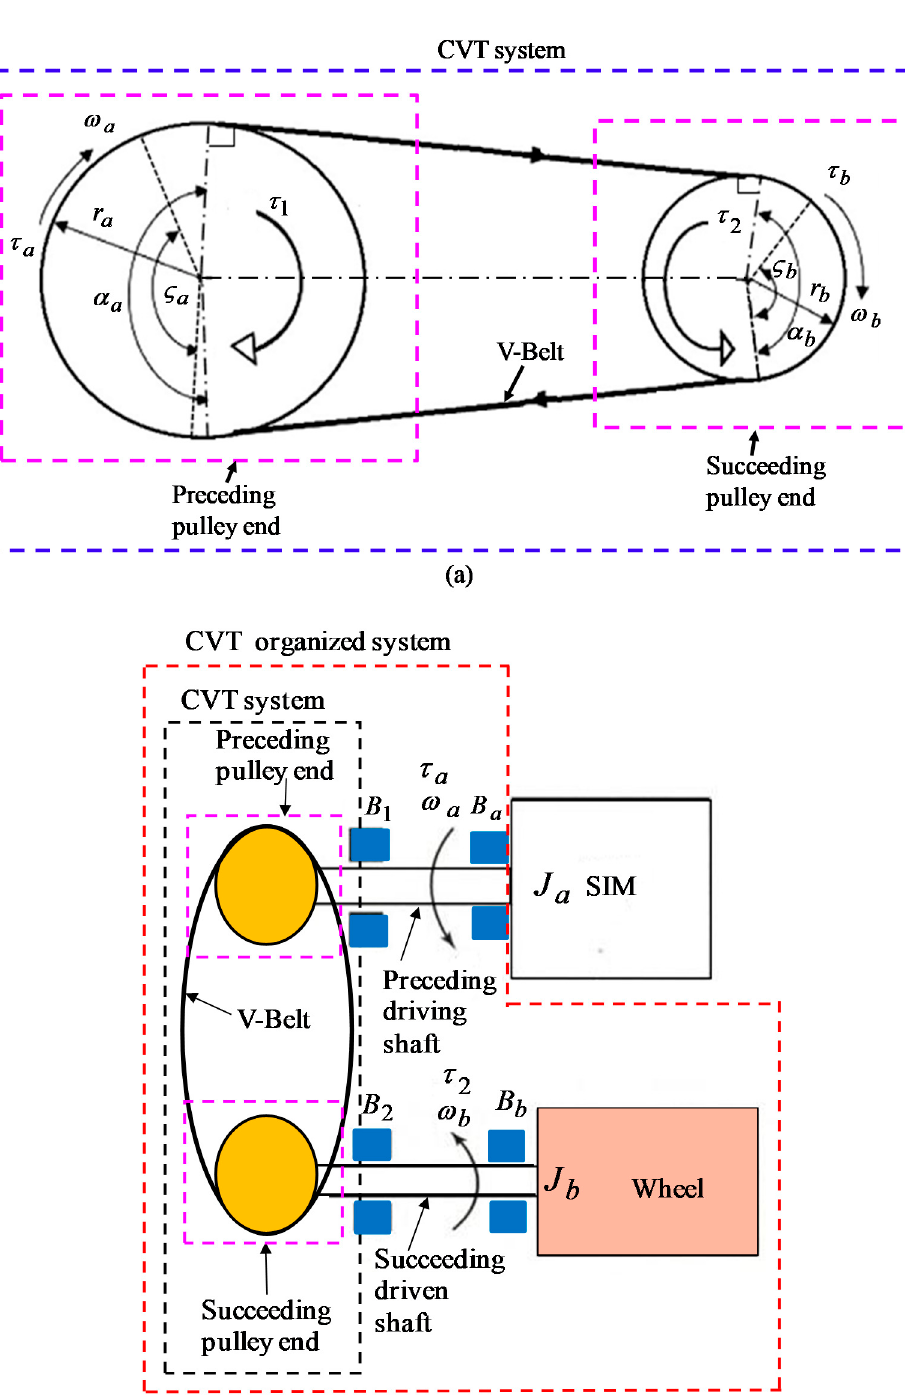
Figure 1. Conformation of the six-phase induction motor (SIM) and continuously variable transmission (CVT) organized system: ( a ) geometric components of the CVT system and ( b ) geometric components of the CVT organized system.